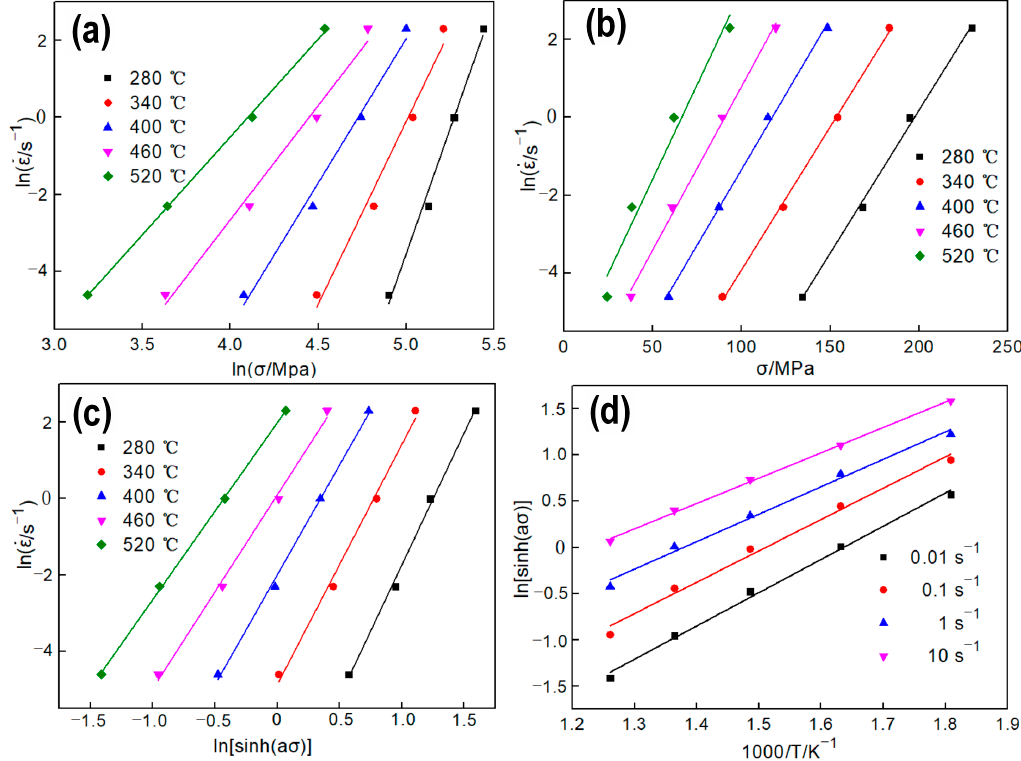
. ε . ε , ( b ) σ − ln , ( c ) σ ε−  σ ε−  , ( b ) ln ,